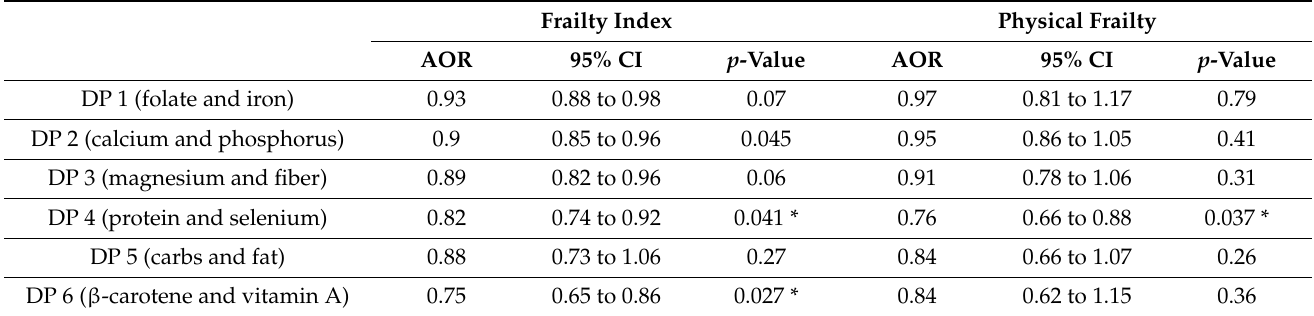
Table 5. Multiple logistic regression analyses a examining the association between dietary patterns and frailty in older adults with olfactory